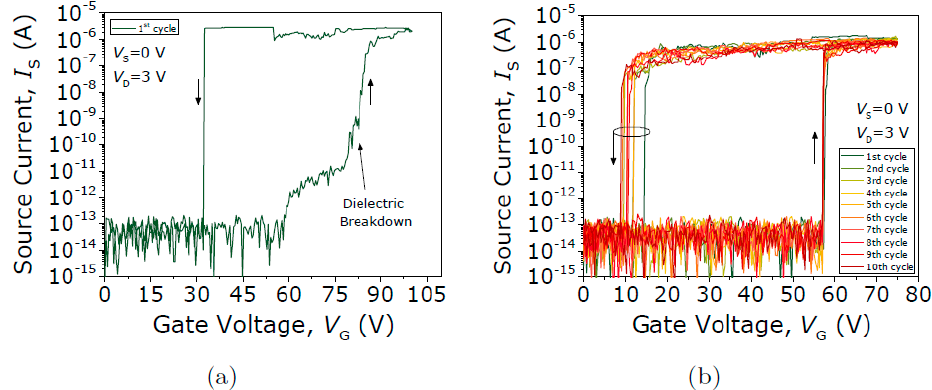
Figure 8. ( a ) First taken current voltage ( I-V ) curve showing no abrupt transition during the pull-in until the breakdown of the native oxide. ( b ) Next 10 current voltage ( I-V ) curves. Measures correspond to the seesaw relay Type II (W-TiN contact) under vacuum conditions.